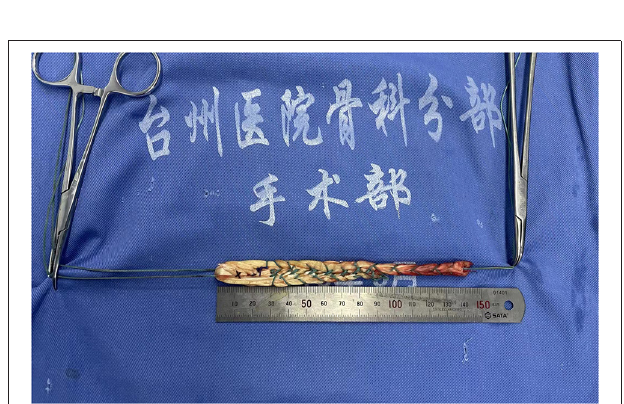
FIGURE 3 | Hamstring tendon of the four strands were stitched into a wide, flat shape. continuity of the coracoacromial ligament. The insertion sites of the supraspinatus and infraspinatus tendon were polished and freshened. An anchor was fixed at the insertion site of the supraspinatus tendon. The supraspinatus or subscapularis were repaired using regular techniques (an additional anchor might be needed for Subscapularis injury). If the supraspinatus muscle could not be pulled back to the footprint area, biceps tendon transfer and anterosuperior augmentation at the insertion site of the supraspinatus tendon were performed. Another anchor was fixed between the upper margin of the pectoralis major muscle and the exit of the biceps pulley. Meanwhile, the biceps tendon was fixed with one suture, and the other suture was left for further procedures.